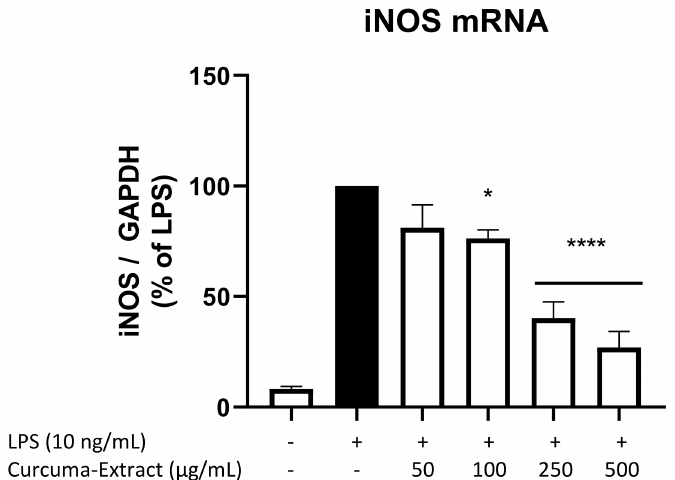
Figure 4. Effects of TE on iNOS mRNA expression in LPS-stimulated BV2 cells. TE was added 30 min before stimulation with 10 ng/mL LPS for 4 h. RNA was then isolated, and iNOS mRNA levels were determined using qPCR. Values are presented as the mean ± SEM of at least three independent experiments. Statistical analysis was performed using one-way ANOVA with Bonferroni post hoc tests and * p < 0.05 and **** p < 0.0001, compared to